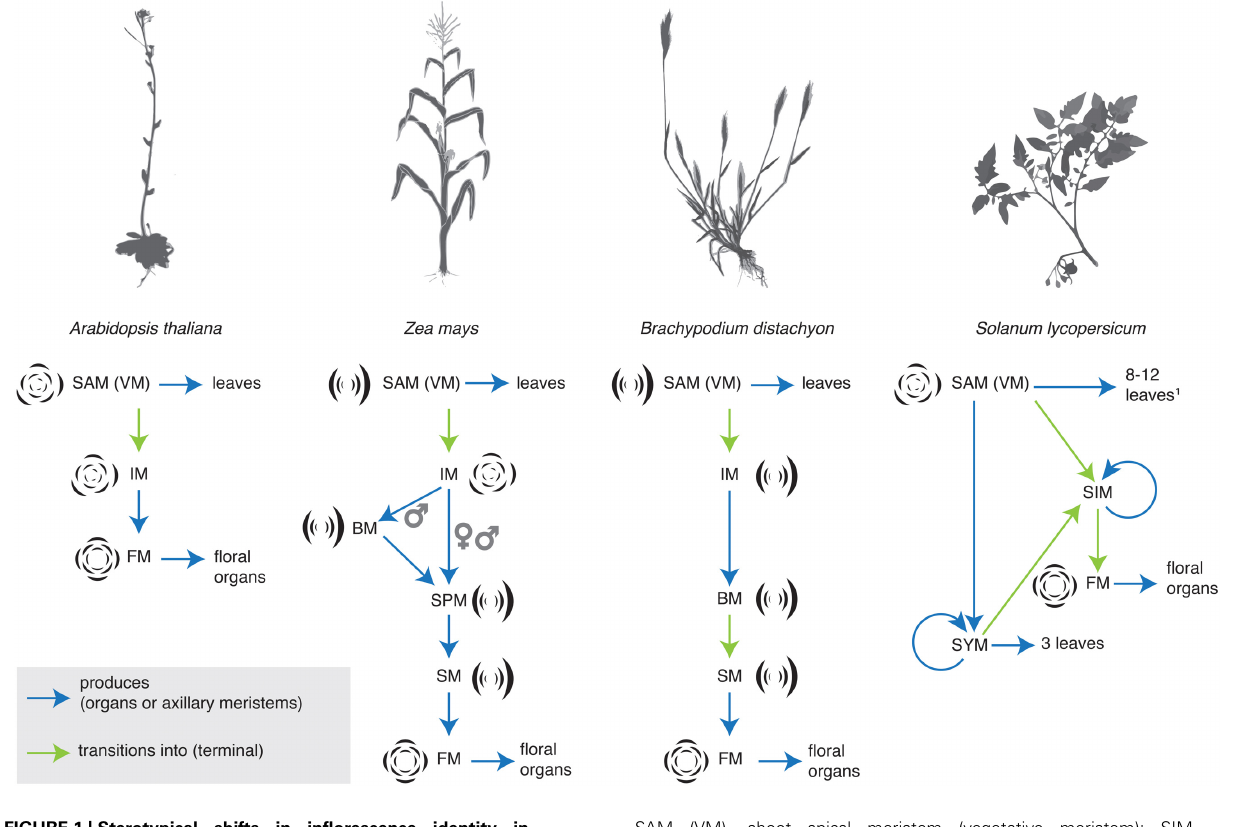
SAM (VM), shoot apical meristem (vegetative meristem); SIM, sympodial inflorescence meristem; SM, spikelet meristem; SPM, spikelet pair meristem; SYM, sympodial shoot meristem (Pnueli et al.,